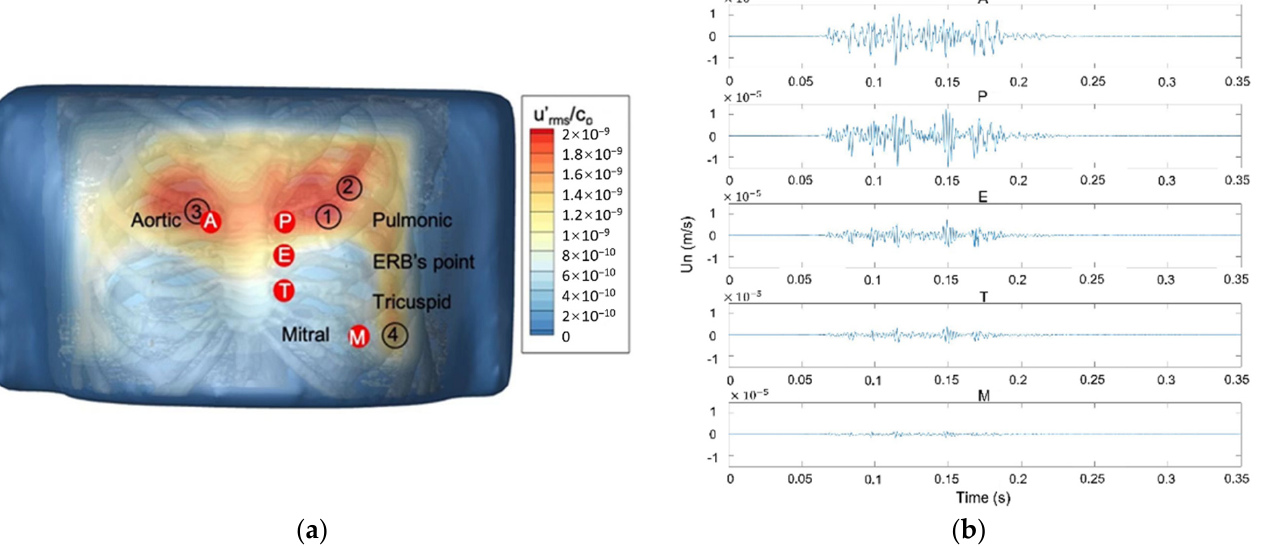
Figure 8. ( a ) The plot of root-mean-squared (rms) wall-normal velocity fluctuation magnitude over the systolic period in the moderate case. Four local maxima: points 1–4. Five standard cardiac auscultation locations: (A) aortic, (P) pulmonic, (E) ERB’s point, (T) tricuspid, (M) mitral; ( b ) the wall-normal velocity versus time at A, P, E, T, and M points.